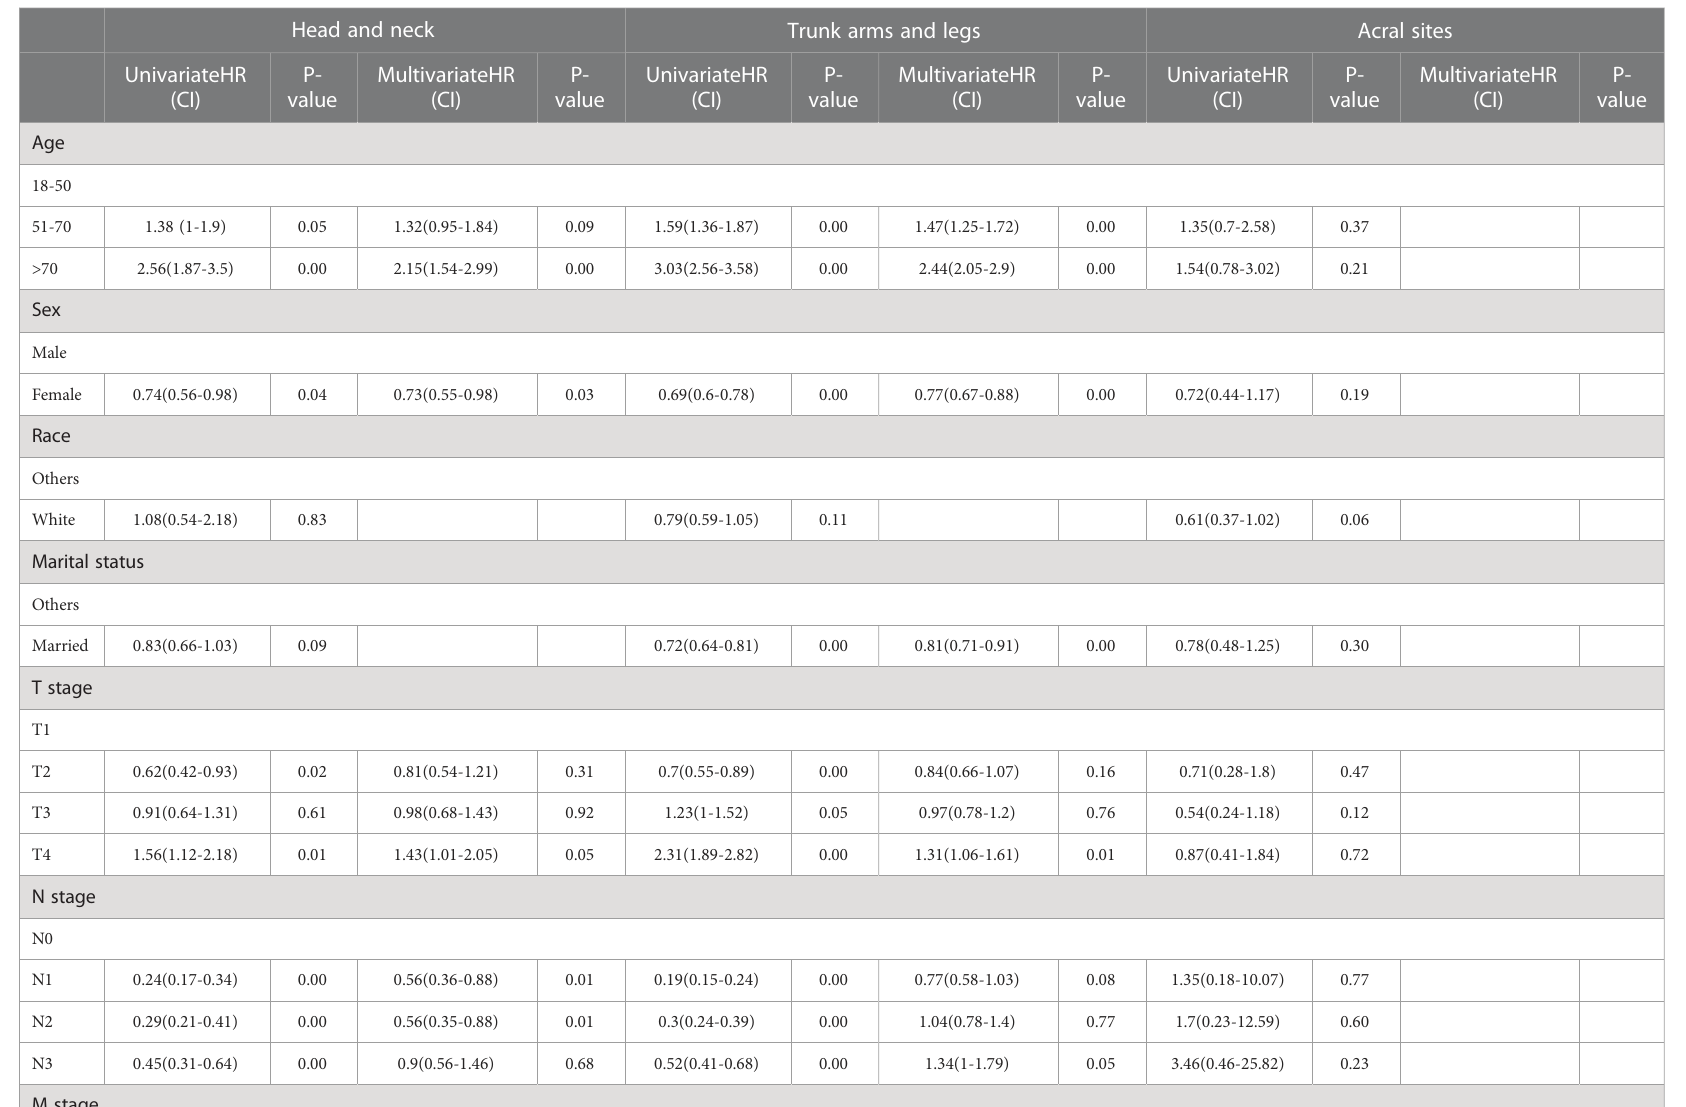
TABLE 4 Univariate and multivariate cox analysis of all cohorts in the ICIS